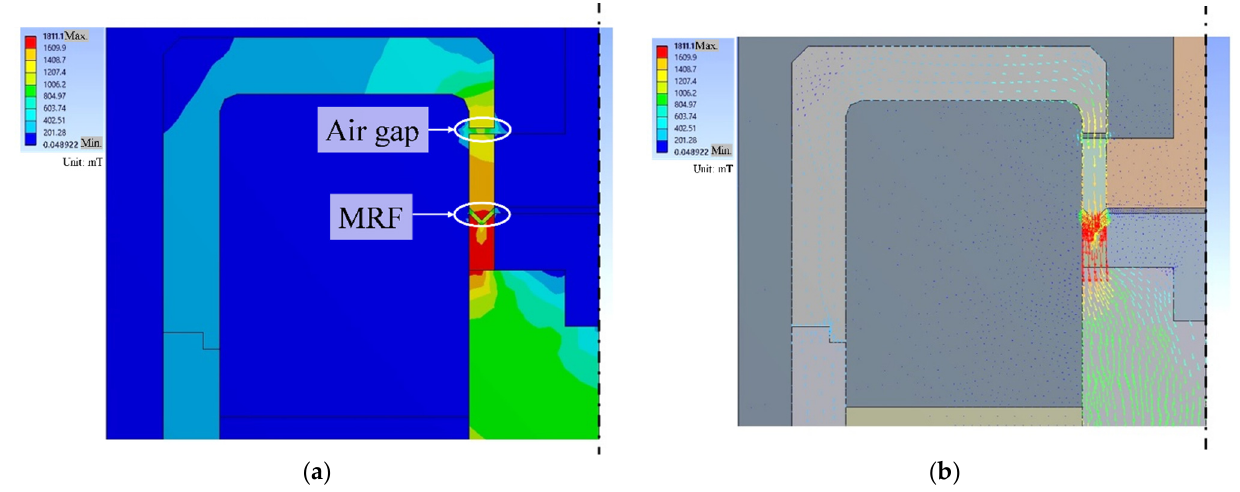
Figure 10. Distribution of magnetic field in the V-shaped plate setting (fluid gap). ( a ) Contour, ( b ) vector.